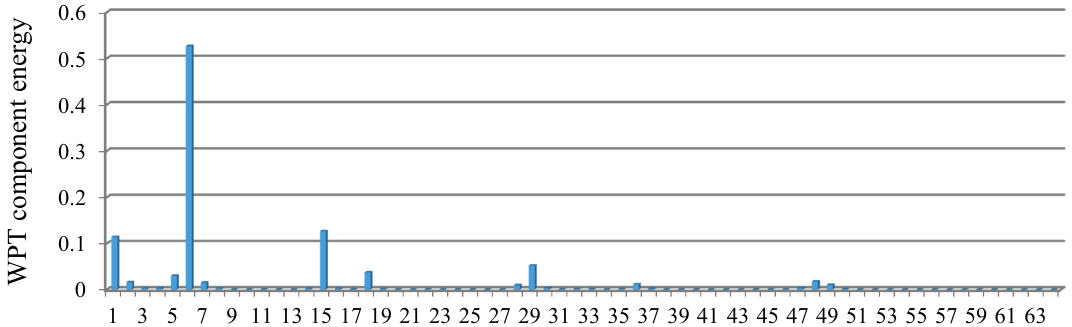
Figure 8. The relative energy distribution of the acceleration response for Case 1.